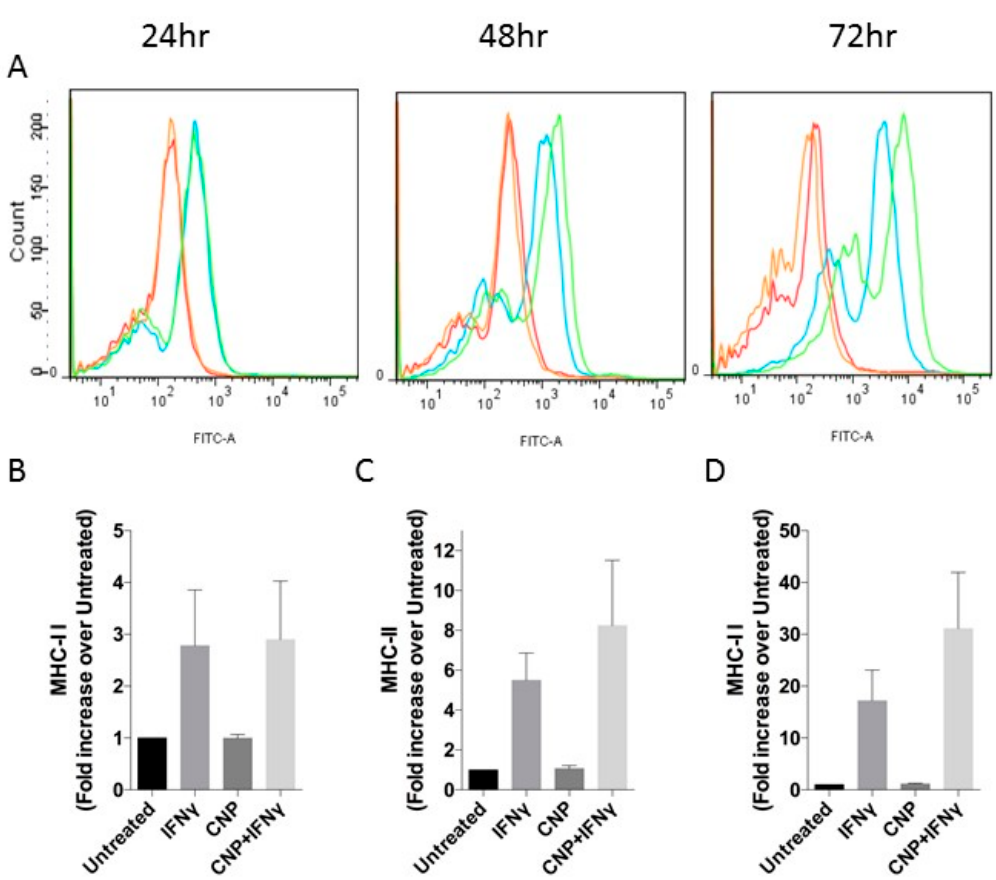
Figure 3. MHC class II expression in HUVEC after incubation with IFN- γ alone or in combinations with CNP for up to 72 h. ( A ) Representative flow cytometry histograms for MHC-II after incubation of HUVEC alone ( Red ) or with IFN- γ ( Blue ), CNP ( Orange ) or IFN- γ and CNP ( Green ) for the indicated times. ( B – D ) Mean Fluorescence Intensity (expressed as fold increase over MFI of untreated cells, which ranged from 187 to 216; mean ± SEM) for MHC-II on untreated HUVEC or after 24 h ( B ), 48 h ( C ) or 72 h ( D ) treatment with IFN- γ alone or in combination with CNP; n = 3 HUVEC isolates.